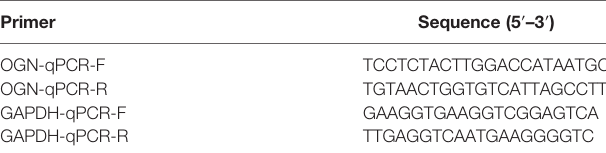
TABLE 2 | Real-time qPCR